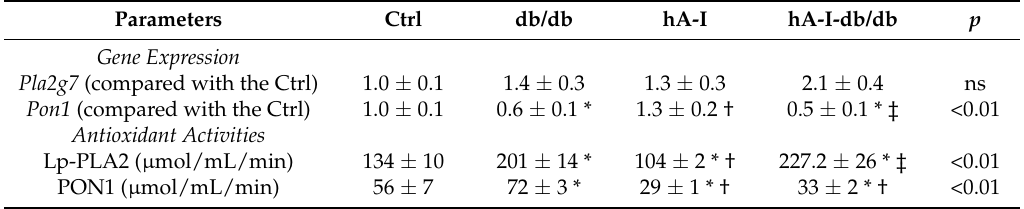
Table 5. Effect of human apoA-I overexpression on hepatic gene expression and plasma levels of antioxidant